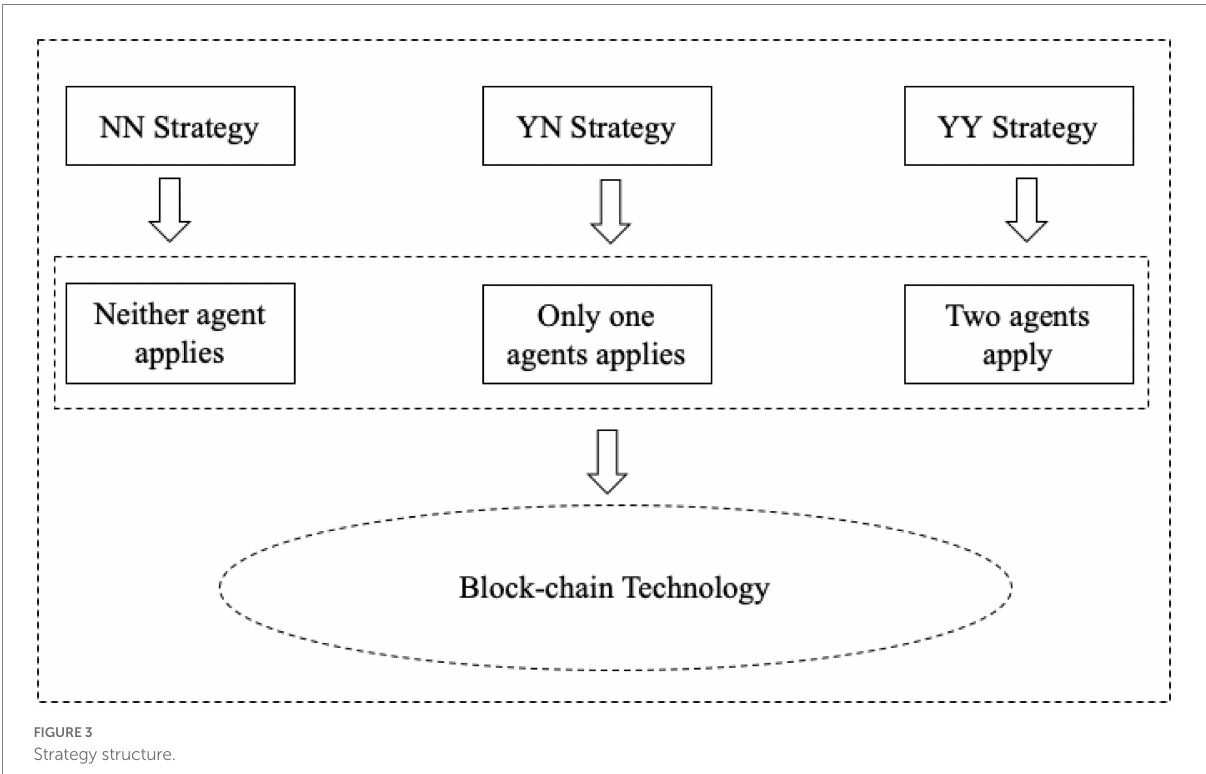
FIGURE 3 Strategy